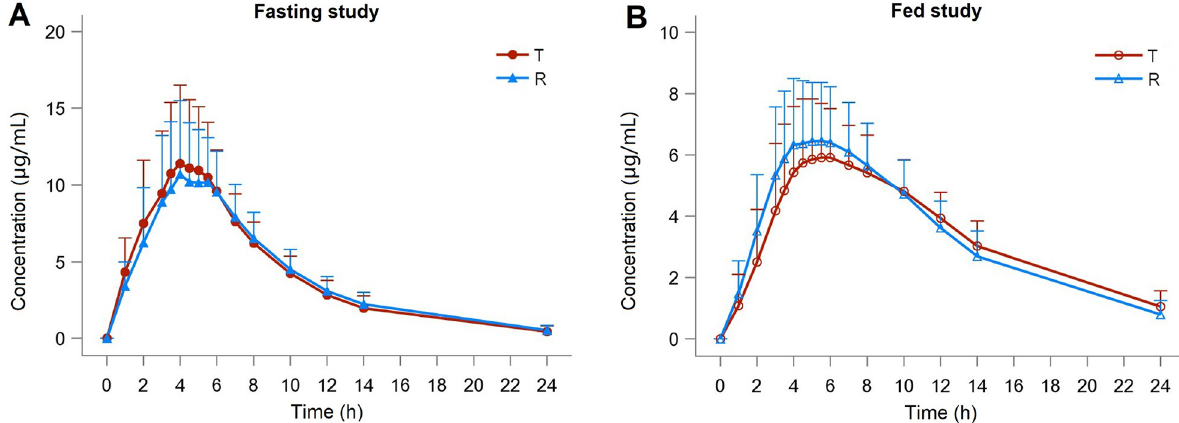
Fig 2. Mean (SD) plasma concentration-time curves for the test and reference of calcium dobesilate capsules 0.5 g after oral administration under fasting (N = 26) and fed (N = 70) conditions in healthy Chinese volunteers.